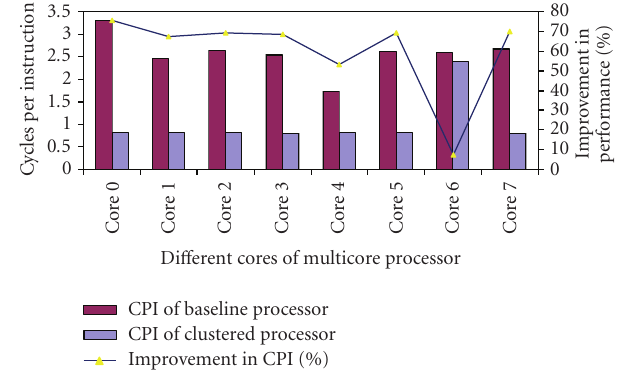
Figure 22: Improvement in average latency for di ff erent type of L2 cache requests-FFT.